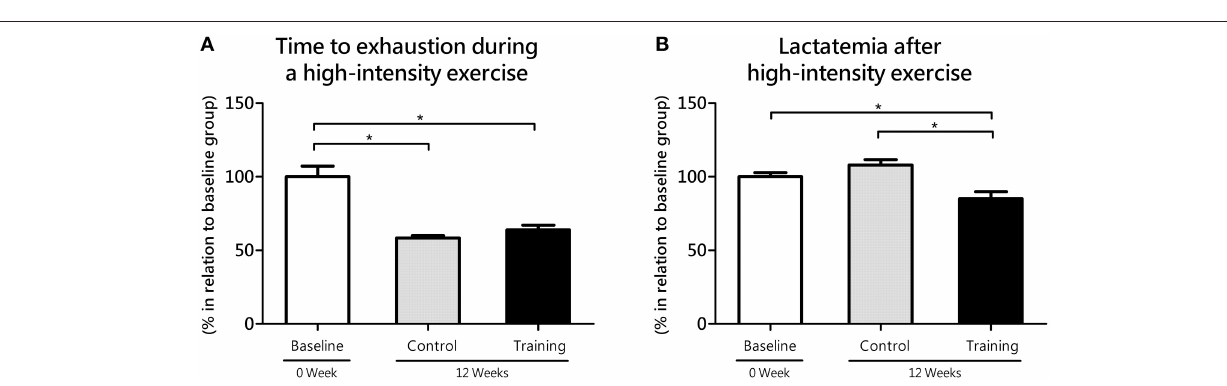
FIGURE 3 | Time to exhaustion during high-intensity exercise (anaerobic parameter, 2nd bout of hyperlactatemia induction at the lactate mininum test; A) and its responses on blood lactate levels (lactatemia after 9min of the anaerobic exercise; B) for the control and training exercise groups. The data (mean ± SEM) are relative (%) to baseline group, which has been set at 100%. Newman-Keuls post-hoc test was used to locate group’s difference. N = 8 –10 animals per group. Sig. diff. * p < 0.05